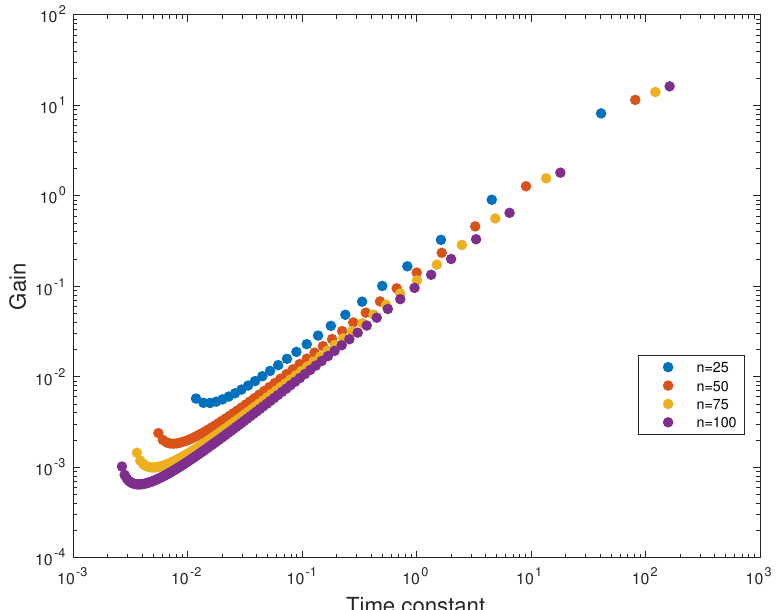
Figure 7. Comparison of time constants and gains of elements of approximating sum for Gauss– Laguerre